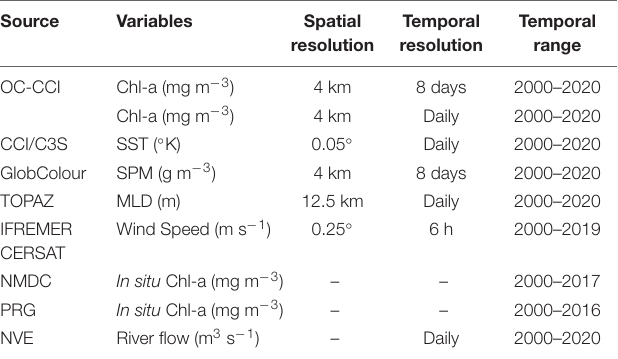
TABLE 1 | Summary of the data used in this